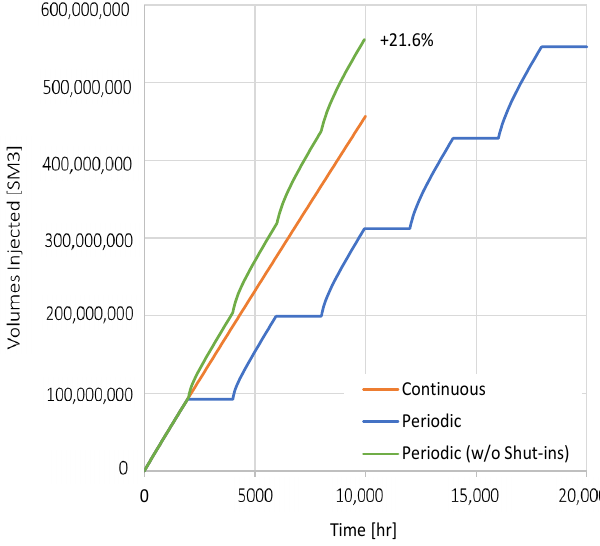
Figure 6. Comparison of CO 2 volumes injected at continuous and periodic injections with cycle half-length of 83 days (Figure 5).